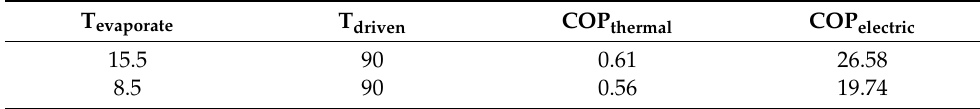
Table 11. Coefficients of performance of the absorption chiller